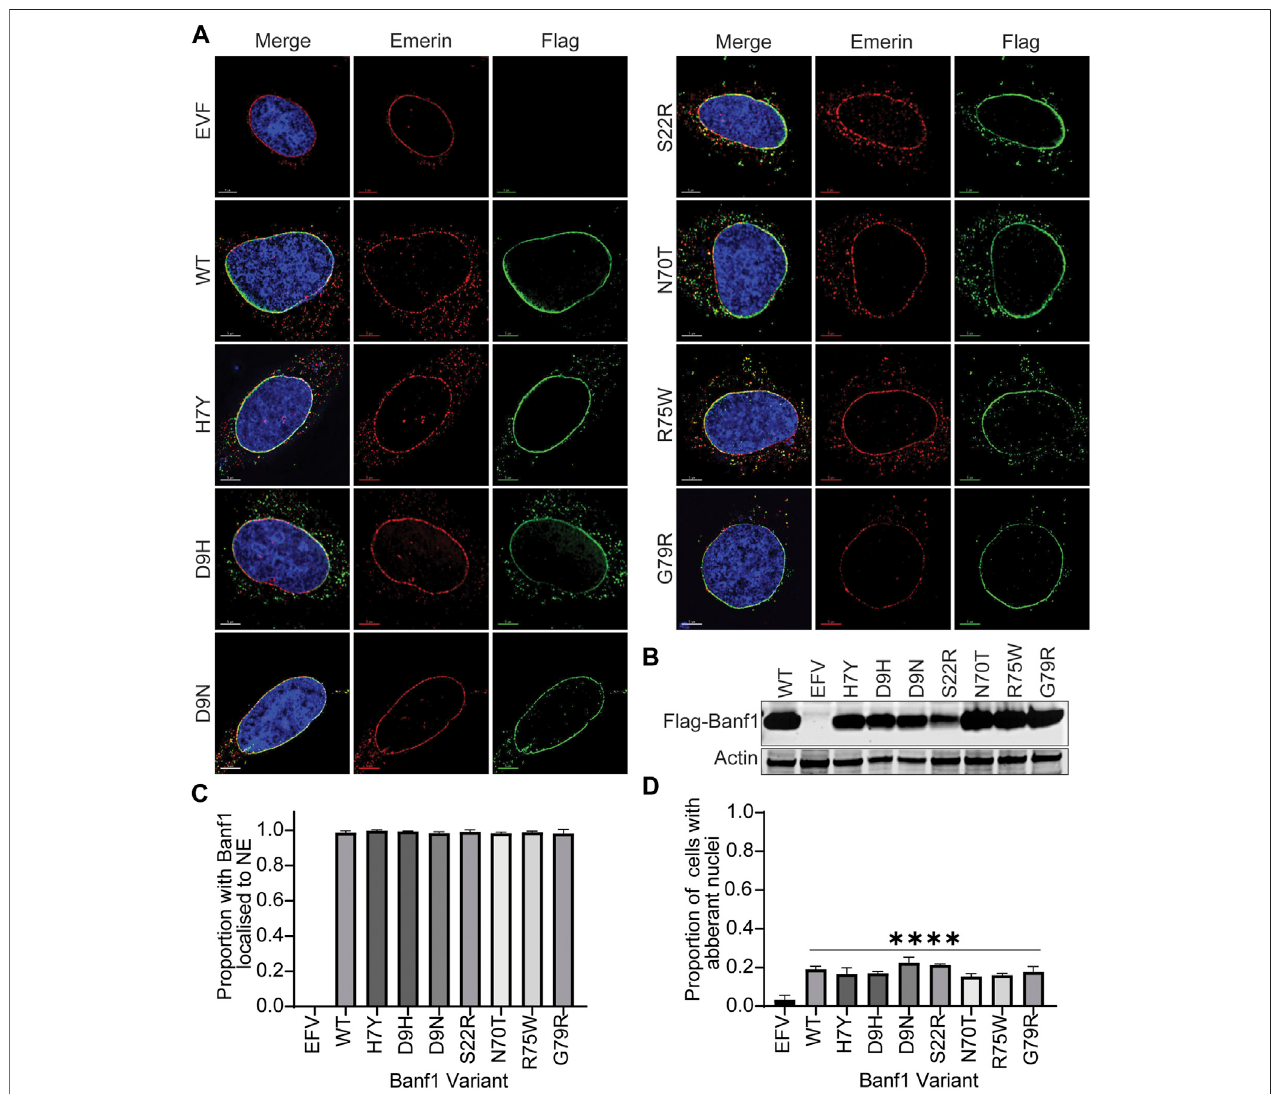
FIGURE4| Banf1variants localisetothenuclearenvelopeanddonotaffectnuclearmorphology. (A) Representativeimmuno fl uorescentmicroscopyimages ofU- 2OScellstransfected withEFV,Banf1WTandBanf1variants.Cellswerestainedwithanti-Flag (Green)antibodyandanti-Emerin(Red)tovisualise thenuclearenvelope. Cells were counterstained with Hoechst 3,342 (blue). (B) Representative immunoblot showing Flag-Banf1 WT and Banf1 variant expression in U-2OS cells. Anti-actin wasutilised asaloadingcontrol. (C) Quanti fi cation oftheproportion ofBanf1WTand variant transfectedU-2OScells withBanf1localised tothenuclear envelope. (D) Quanti fi cation of aberrant nuclei in with EFV, Banf1 WT and Banf1 variant transfected U-2OS cells. Quanti fi cations are based on 200 cells/condition in at least three independent experiments. Error bars denote standard deviation of the mean. EFV: empty Flag vector control. *** p < 0.001.